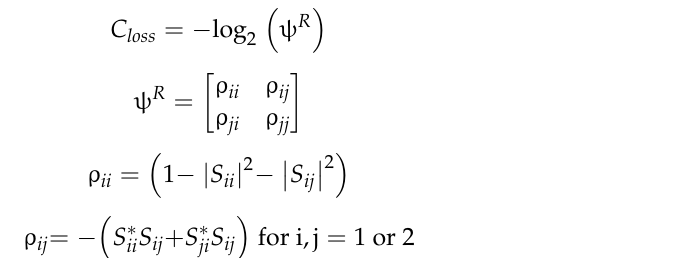
Equations (4)–(7) [9]: